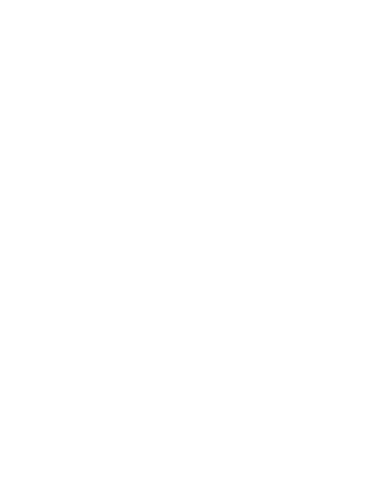
Figure 5. The mass ratio of pulverized coal under different simulation